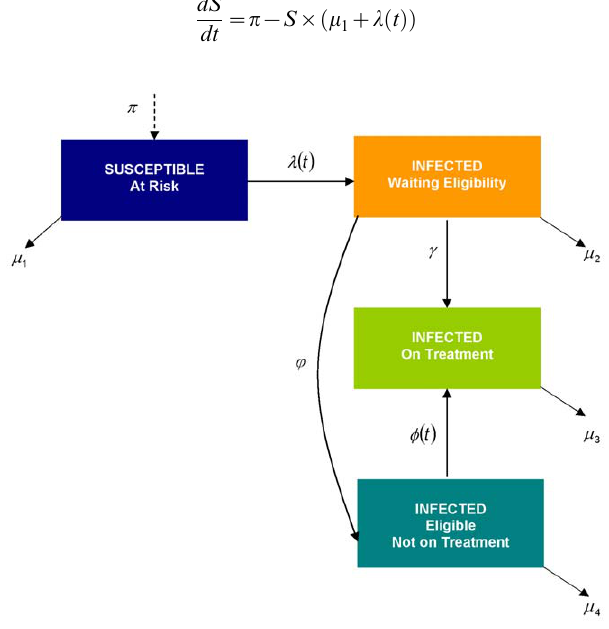
Figure 1. Transmission Model. This diagram shows the distribution of the population at a given point in time. The arrows indicate the movement of individuals across infectivity strata. Parameters’ explana- tion and value are displayed in Table S1.